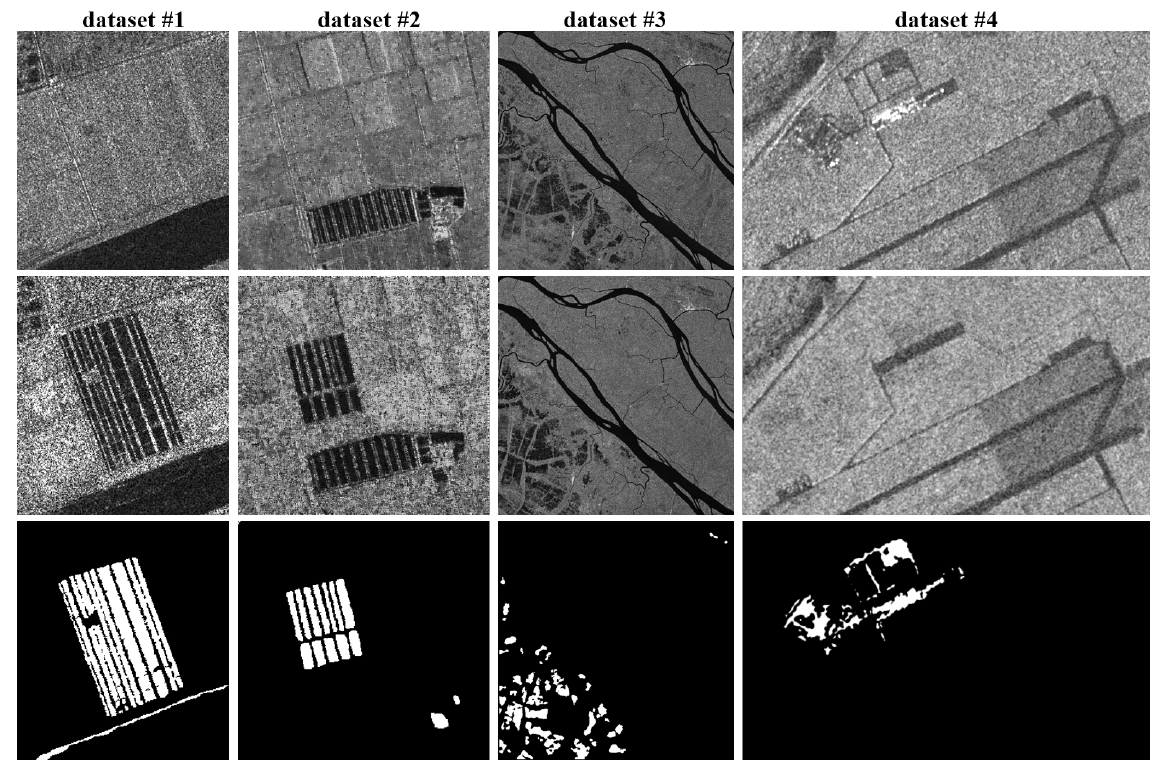
Figure 3. Four experimental bi-temporal SAR datasets. From the first column to the fourth column are Dataset #1, Dataset #2, Dataset #3, Dataset #4, respectively. Each column refers to (cid:104) image t 1 ; image t 2 ; ground truth (cid:105)